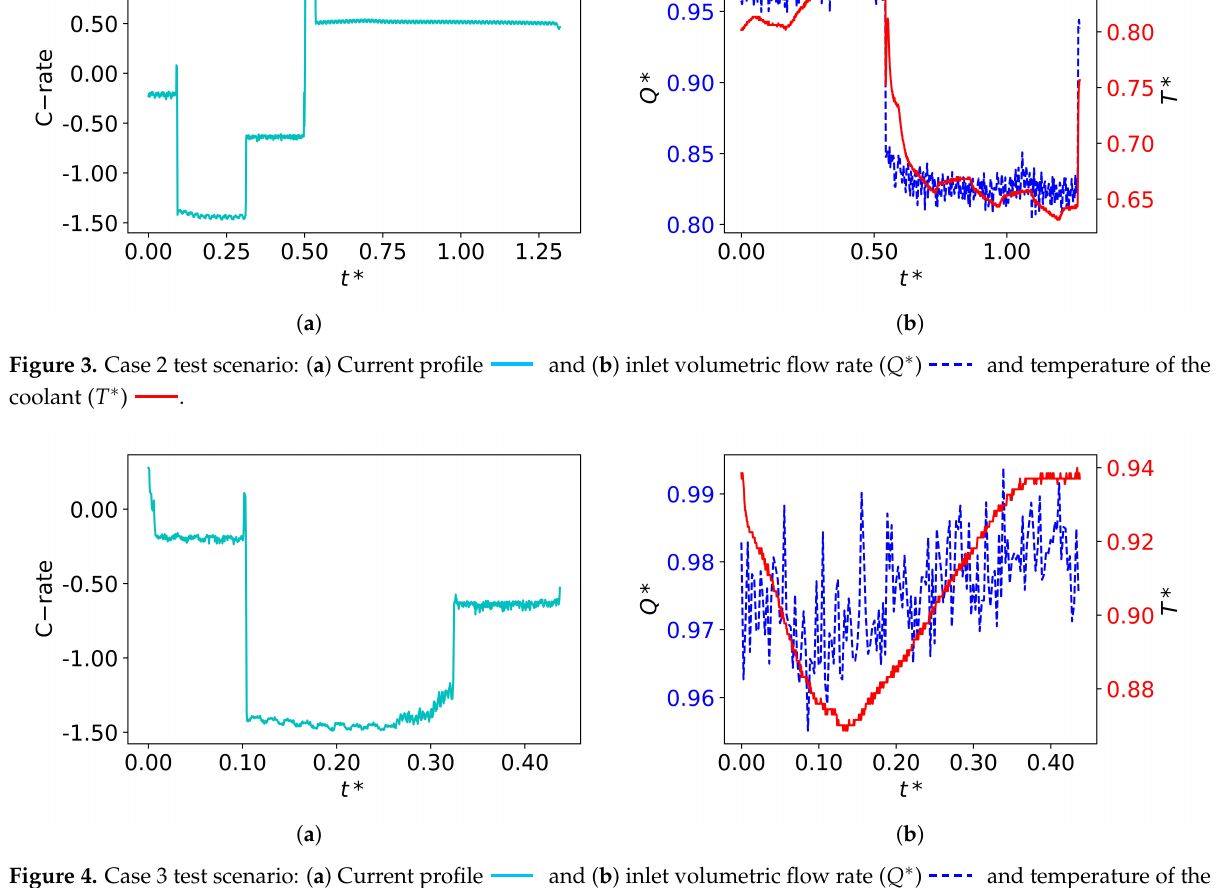
Figure 4. Case 3 test scenario: ( a ) Current profile and ( b ) inlet volumetric flow rate ( Q ∗ ) and temperature of the coolant ( T ∗ ) .